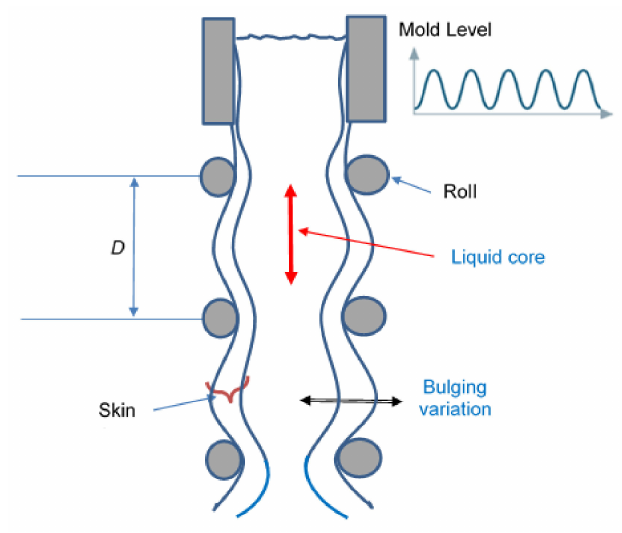
Figure 5. Formation of bulging